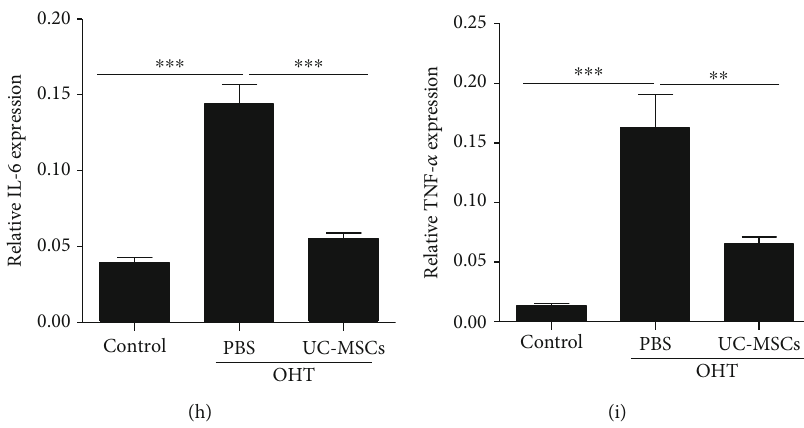
Figure 6: hUC-MSC transplantation decreases the expression of TLR4 pathway-related agents and proin fl ammatory mediators in the OHT-induced rats. Two weeks after hUC-MSC injection. (a – d) Relative gene expression of MyD88, IL-1 β , IL-6, and TNF- α that was normalized to GAPDH in retinas from normal eyes, OHT+PBS eyes, and OHT+hUC-MSC eyes ( n = 4/group ; ∗ P < 0 : 05 and ∗∗∗ P < 0 : 001 compared with one-way ANOVA with Turkey ’ s post hoc tests). (e) Western blot analysis for MyD88, IL-1 β , IL-6, and TNF- α from normal eyes, OHT+PBS eyes, and OHT+hUC-MSC eyes. (f – i) Relative protein expression of MyD88, IL-1 β , IL-6, and TNF- α that was standardized to actin ( n = 4/group ; ∗ P < 0 : 05 , ∗∗ P < 0 : 01 , and ∗∗∗ P < 0 : 001 compared with one-way ANOVA with Turkey ’ s post hoc